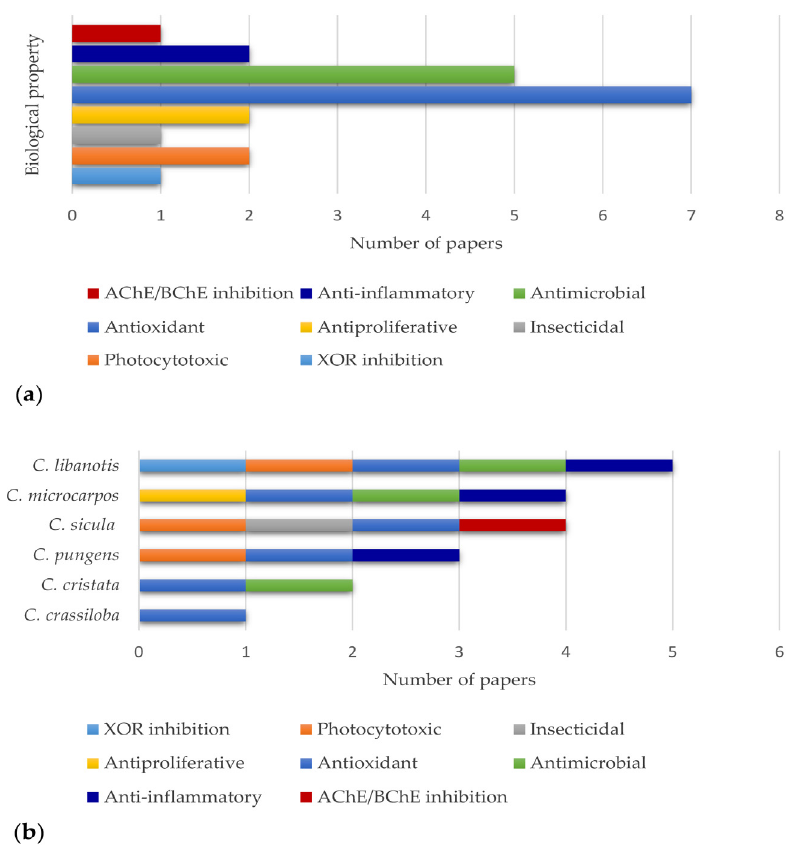
Figure 4. Biological properties reported for Cachrys spp. ( a ) Number of articles focusing on each reported biological activity. ( b ) Number of papers focusing on the biological properties of each